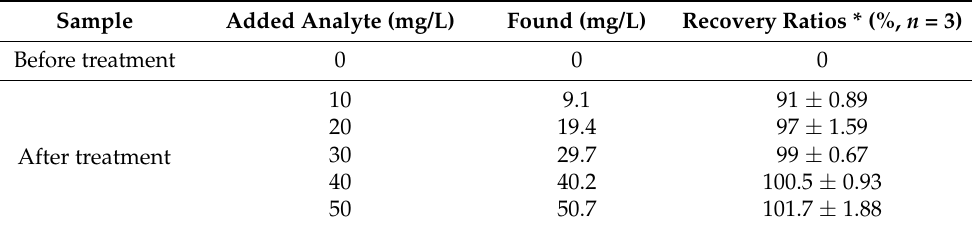
Table 2. Detection of Hg ions in real water